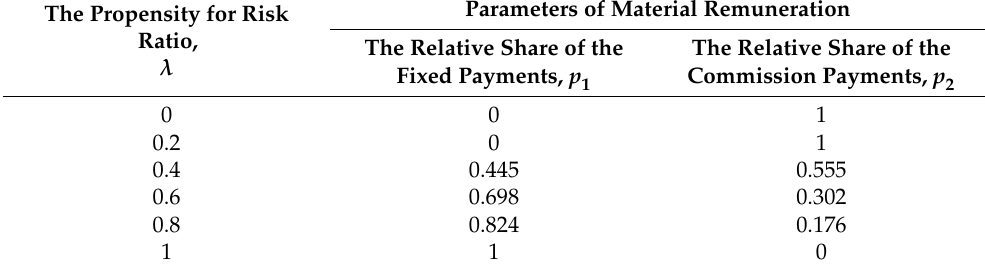
Table 2. Parameters of the optimal structure of the fixed and commission-based material remuneration package for the project group employees of Energoatom’s systems integration department obtained by maximizing their utility function. Parameters of Material Remuneration The Propensity for Risk Ratio, The Relative Share of the The Relative Share of λ Fixed Payments, p 1